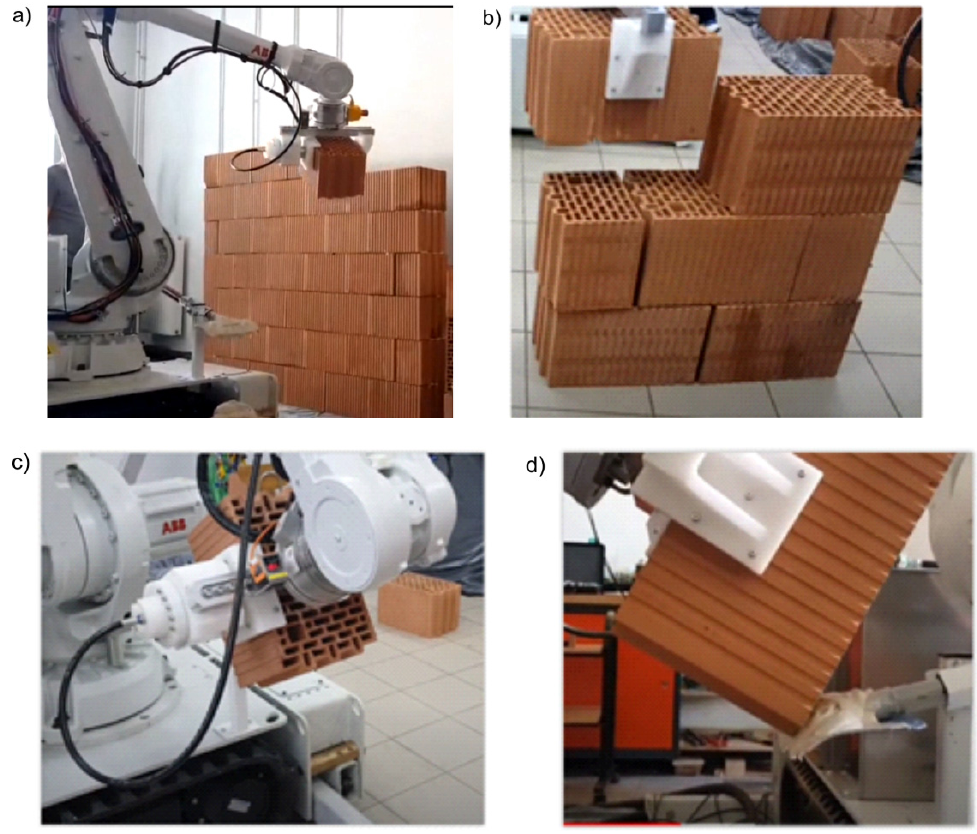
Figure 2. View of the bricklaying process ( a ), bricklaying robot while laying bricks ( b ), laying bricks in the wall ( c ), applying mortar on bricks ( d ). in the wall ( c ), applying mortar on bricks ( d